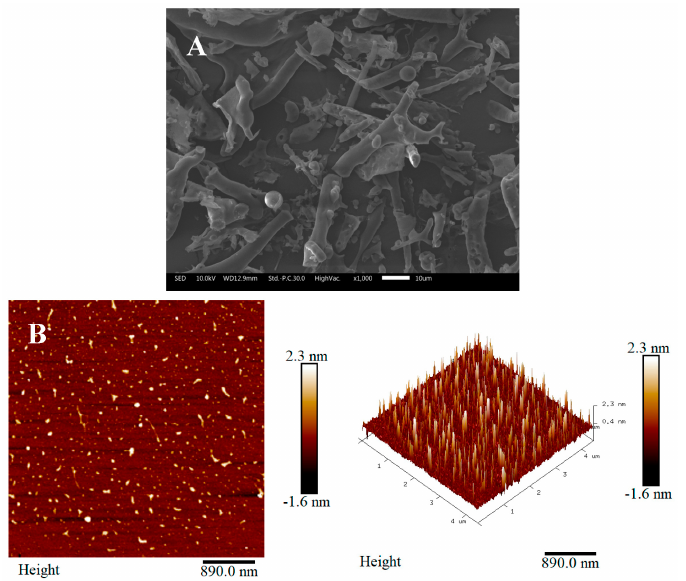
Figure 6. ( A ) Scanning electron micrographs of the IC-FWBP; ( B ) atomic force microcopy images of the IC-FWBP.